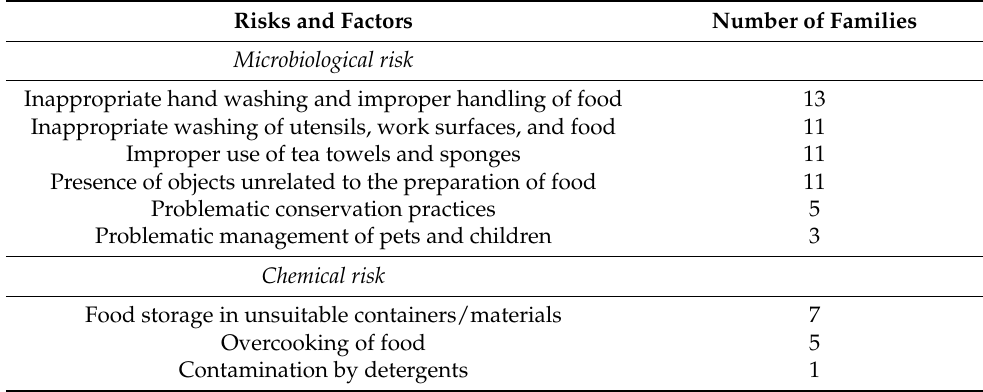
Table 2. Practices and factors that facilitate food-related risks and number of families in which they were